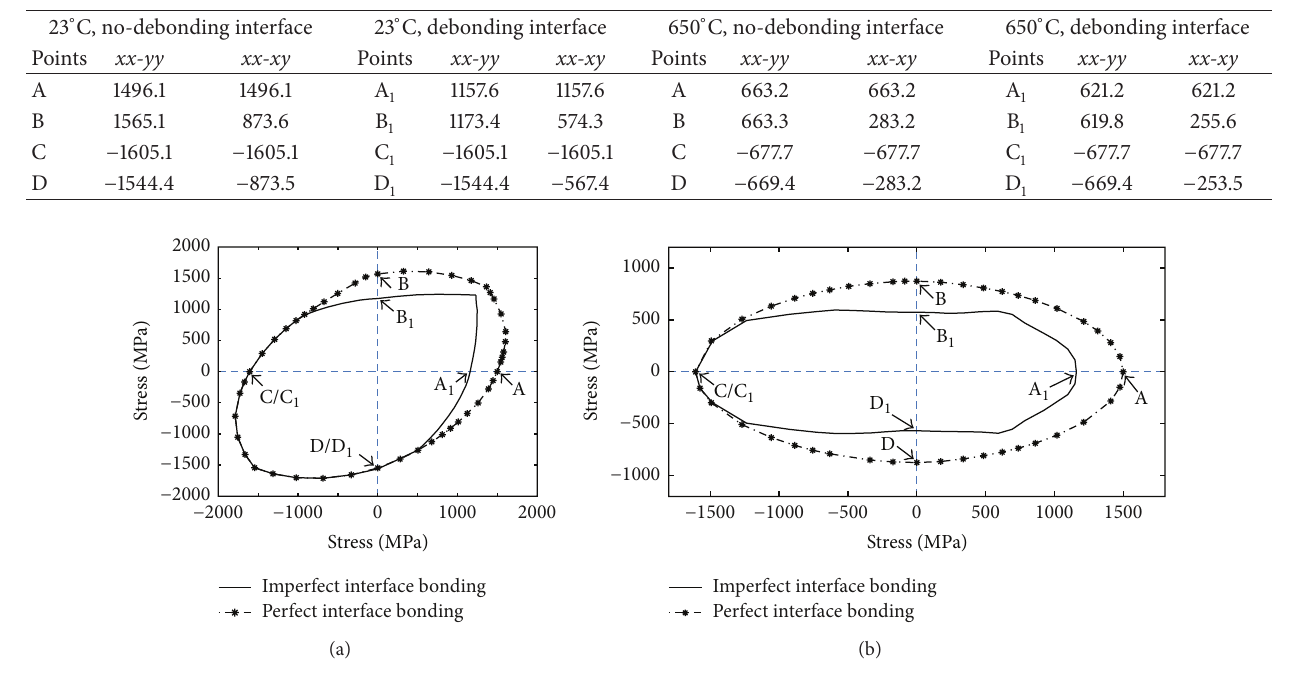
Figure 3: The failure envelopes of [0//90]